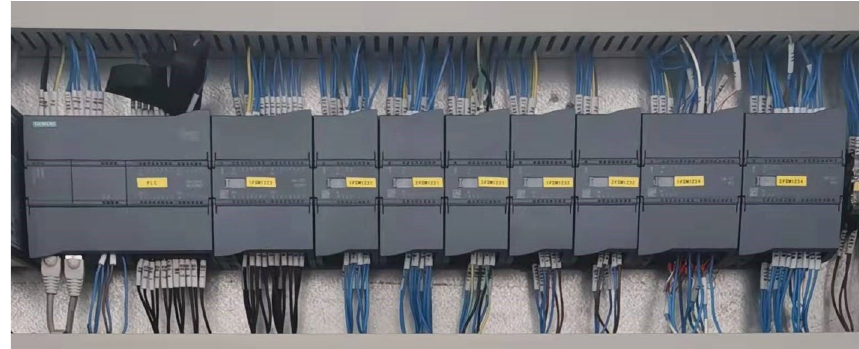
Figure 4. The PLC module in the EXP.